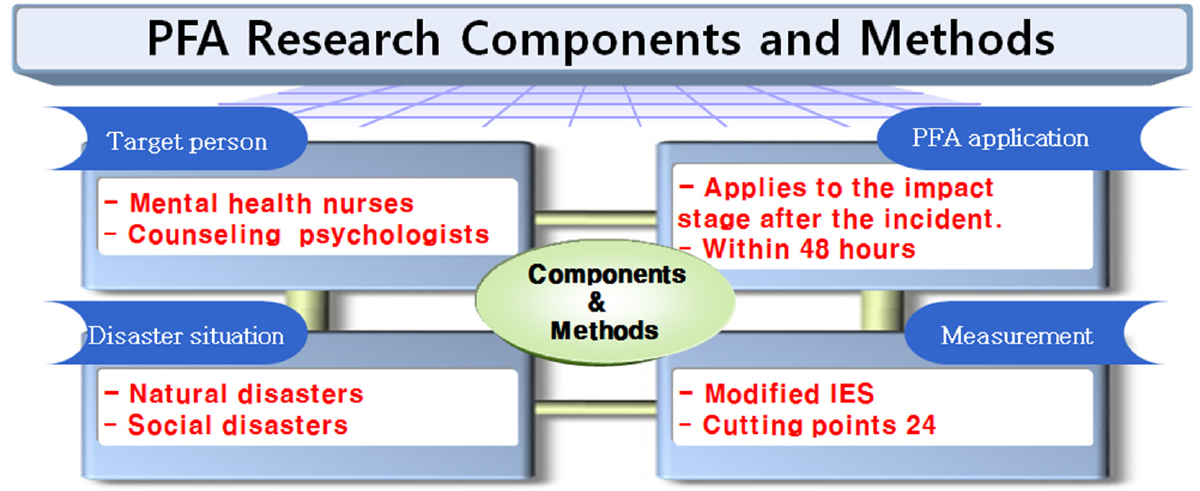
Figure 1. PFA research components and methods.